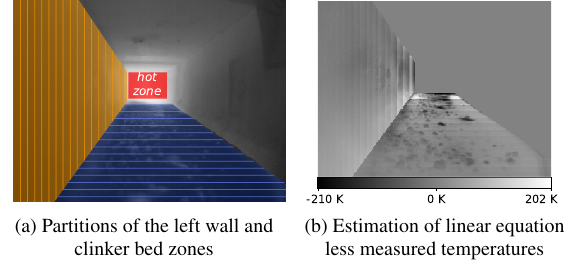
Figure 5. Partitioning and results of the linear model.